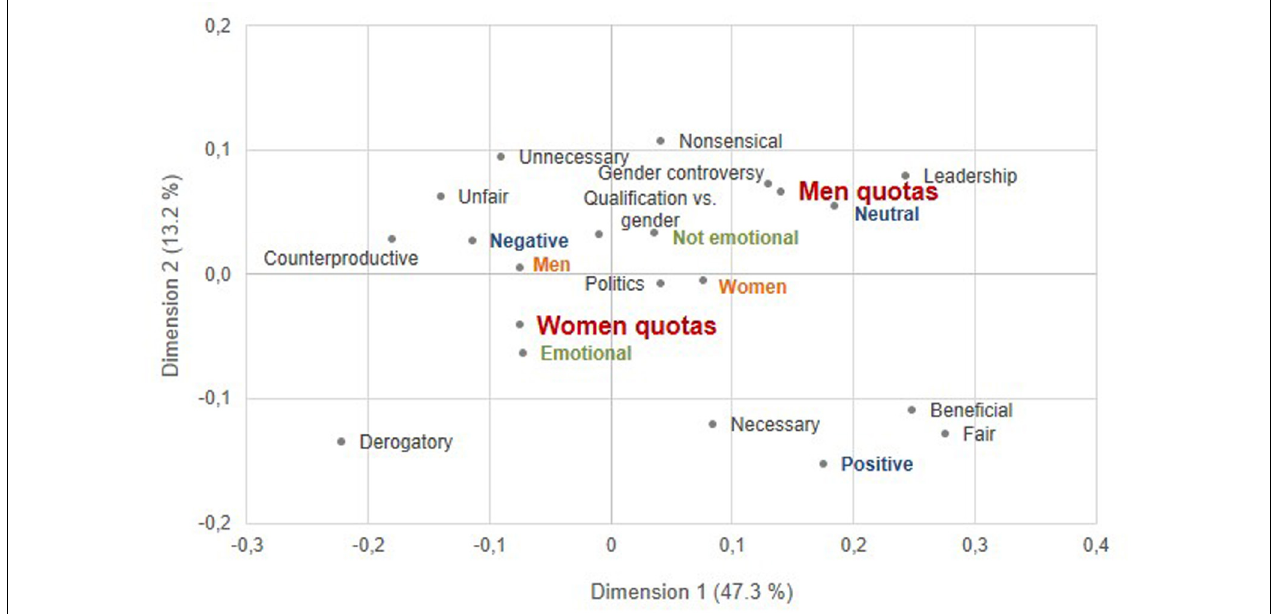
FIGURE 1 | Biplot of the multiple correspondence analysis with the stimuli women quotas and men quotas (red), participant gender (orange), association valence (blue), association emotionality (green), and association category (gray). The biplot is interpreted by examining the position of the variables (i.e., gender, valence, emotionality) and the semantic content (i.e., the categories) along Dimension 1 and 2 (Greenacre and Blasius, 2006). In addition, the spatial distance between the variables and the semantic content reflects their relationships to each other. The closeness of points to each other represents the frequency of connections in the data (Abdi and Valentin,